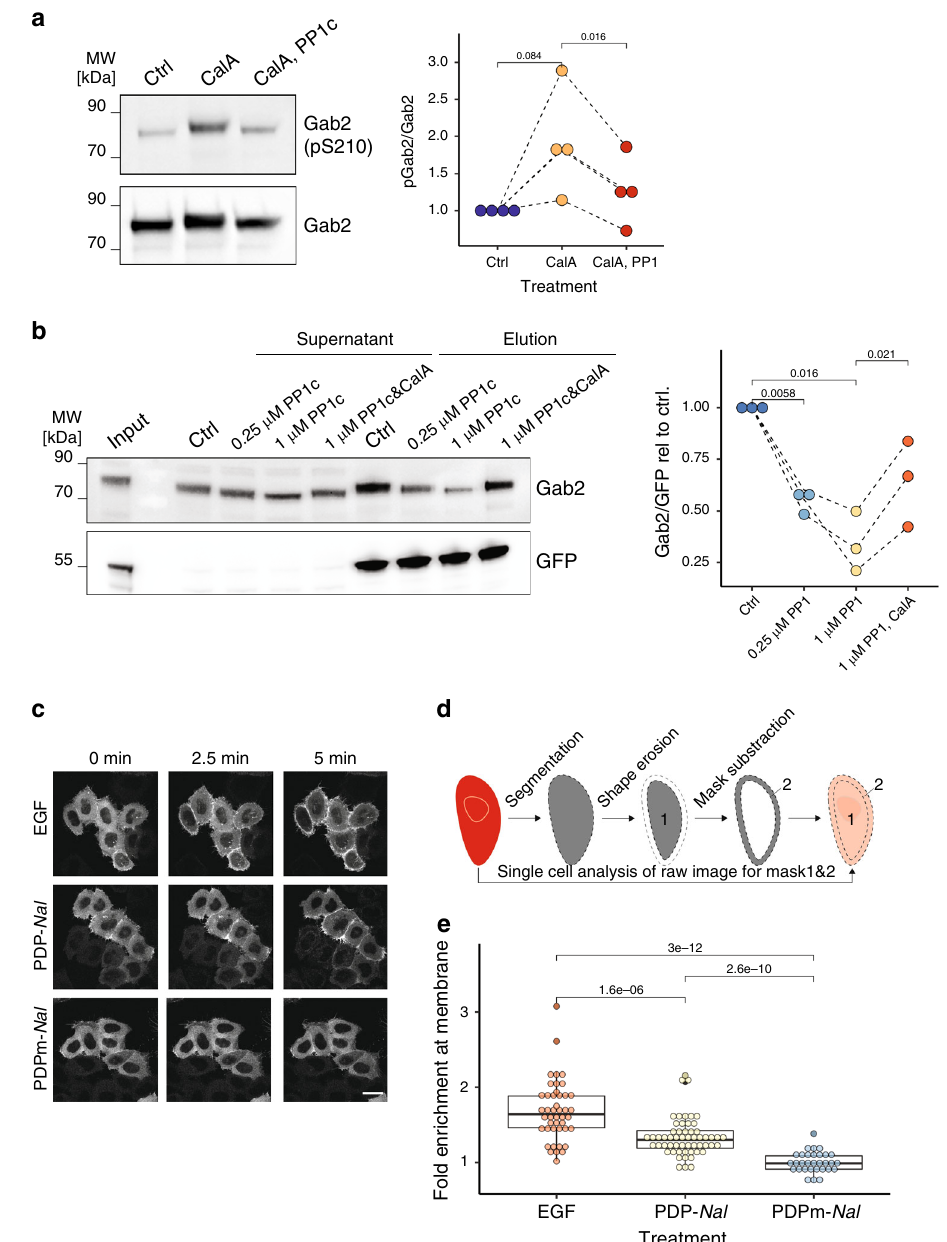
Fig. 6 GAB2 is regulated by PP1. a Dephosphorylation detected by Western Blot. GAB2-pS210 signal relative to GAB2 is quanti fi ed on the right. Shown is one representative experiment out of three independent repeats (CalA: Calyculin A). Four independent repeats have been quanti fi ed on the right. p -Values are derived from a t-test (two-sided, paired). b Overexpressed GFP-14-3-3 β is less associated with endogenous GAB2 upon PP1c treatment. Inhibition of PP1c with calyculin A (CalA) abolishes the effect. Quanti fi cation depicts results of three independent experiments with p -values obtained from t-tests (two- tailed, paired). For a, b: Samples were derived from the same experiment and gels/blots were processed in parallel. c Confocal microscopy images of pmKate2-Gab2 signal in live HeLa Kyoto cells are shown after the indicated treatments. Stimulus was added after 45 s, scale bar represents 25 µ m. (see also Supplementary Movies 1-3) d Scheme of image analysis for calculating GAB2 enrichment at the plasma membrane. e Fold-enrichment of GAB2 at the plasma membrane, as determined by comparing 0 min and 5 min frames. Each point represents a single cell ( n = 44/56/31 for EGF/PDP- Nal /PDPm- Nal ). Statistics represent adjusted p -values of a two-sided Wilcoxon test. Boxplots highlight median and 1st/3rd quartile. Whiskers refer to the lowest and highest data points that are within a 1.5-fold interquartile range. Source data of Fig. 6a, b, and e are provided as a Source Data fi